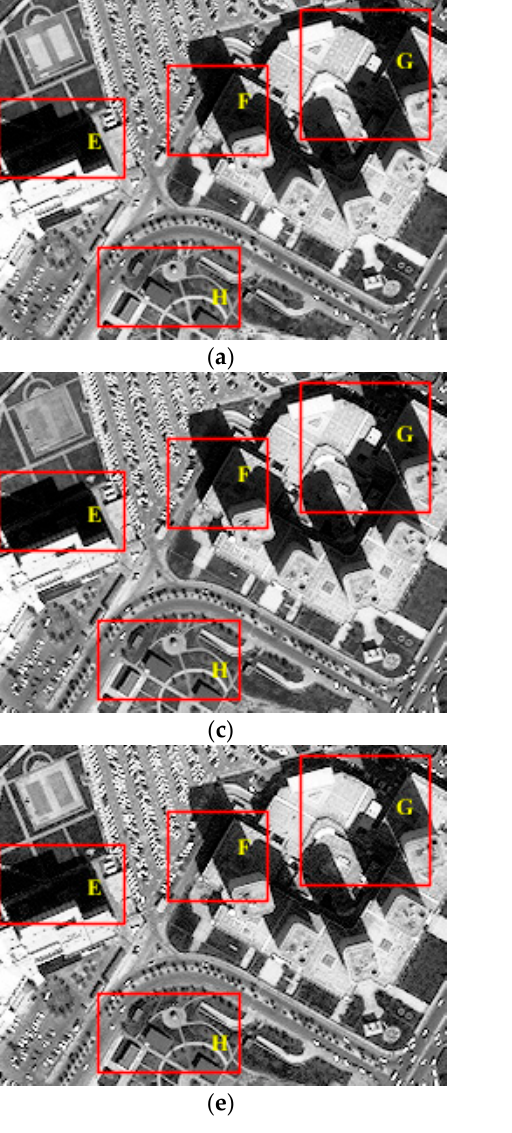
Figure 5. Resulting images of the test image Tripoli-2 compensated before and after by the IRB shadow compensation algorithm in terms of R, G and B components. ( a ) R before shadow compensation. ( b ) R after shadow compensation. ( c ) B before shadow compensation. ( d ) B after shadow compensation. ( e ) G before shadow compensation. ( f ) G after shadow compensation.